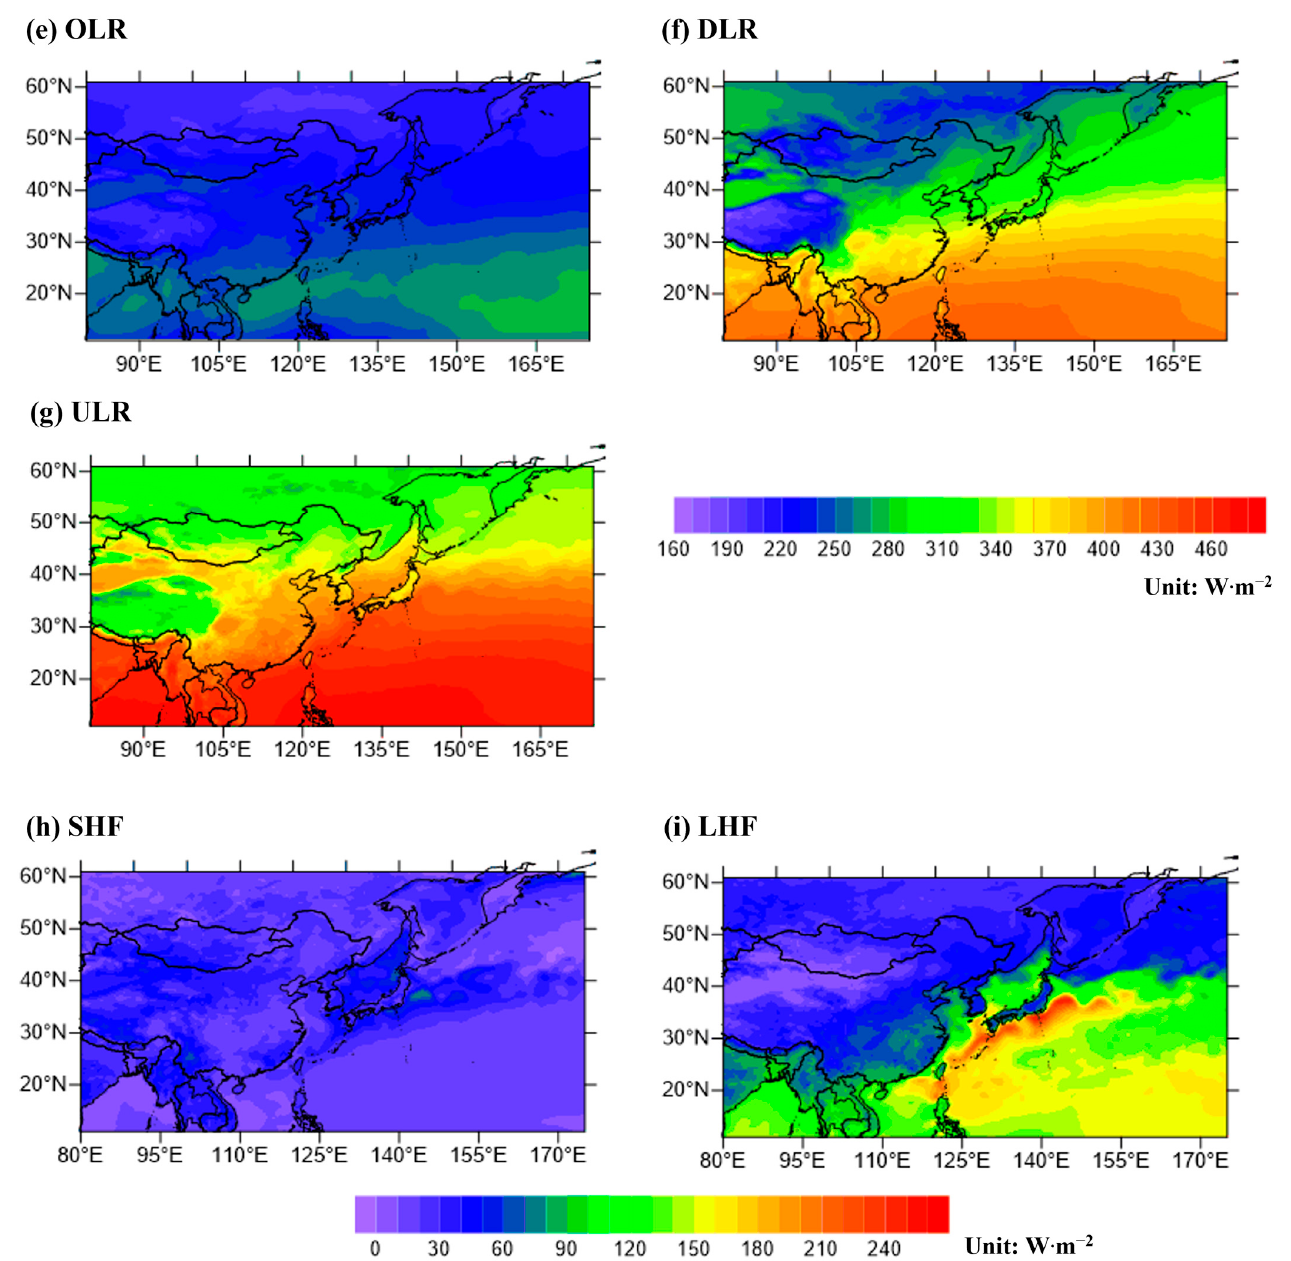
Figure 5. Annual mean values of ( a ) ISR, ( b ) RSR, ( c ) DSR, ( d ) SSR, ( e ) OLR, ( f ) DLR, ( g ) ULR, ( h ) SHF and ( i ) LHF over East Asia region for the year of 2021.